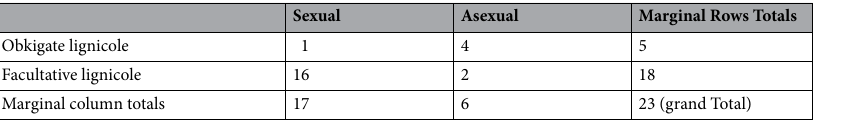
Sexual Asexual Marginal Rows Totals Obkigate lignicole 1 5 Marginal column Table 2. Significance of the association between species´ reproduction modes and substrate preferences studied by Fisher Exact Test. The test statistic value is 0.0078, and the result is significant at p < .01.